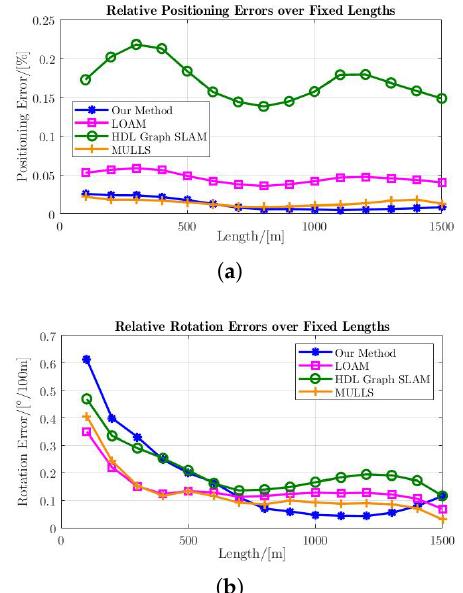
Figure 15. The average RTE and RRE of LO systems over fixed lengths. ( a ) RTE; ( b )